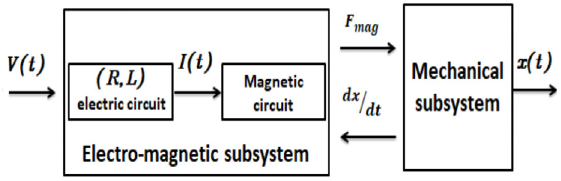
Figure 3 Mathematical model representation.